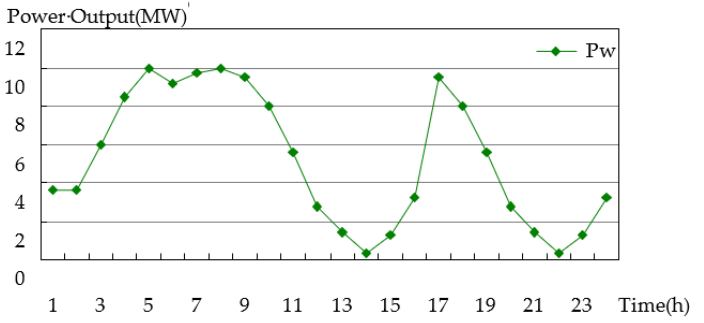
Figure 4. Forecast wind power of a day in spring.